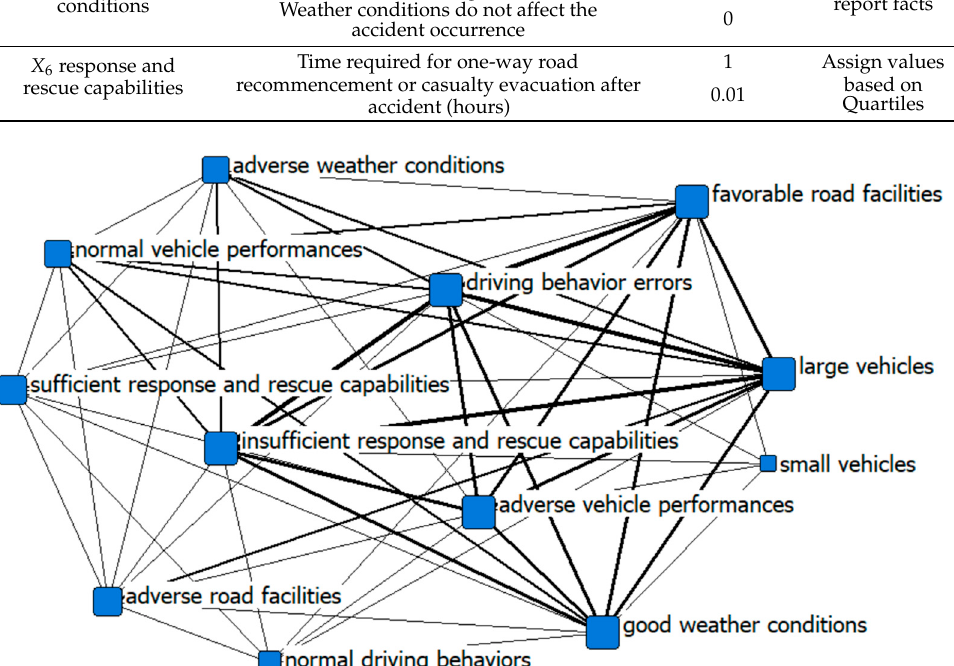
Figure 2. The social network analysis of major road accidents.